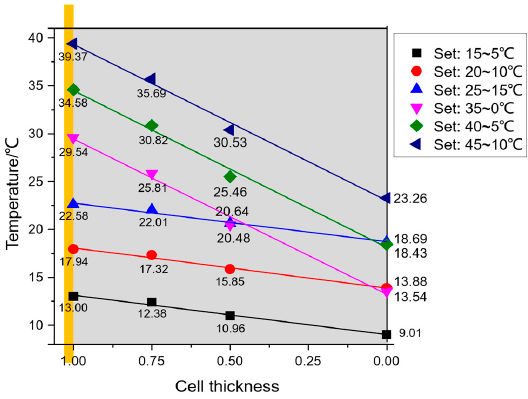
Figure 12. Temperature distribution inside battery.